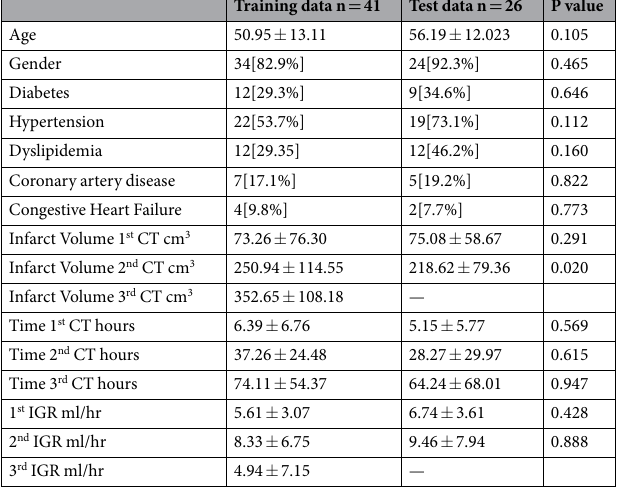
Table 1. Data used for training ANFIS and testing for all methods used. Values are mean with percentage, mean age with standard